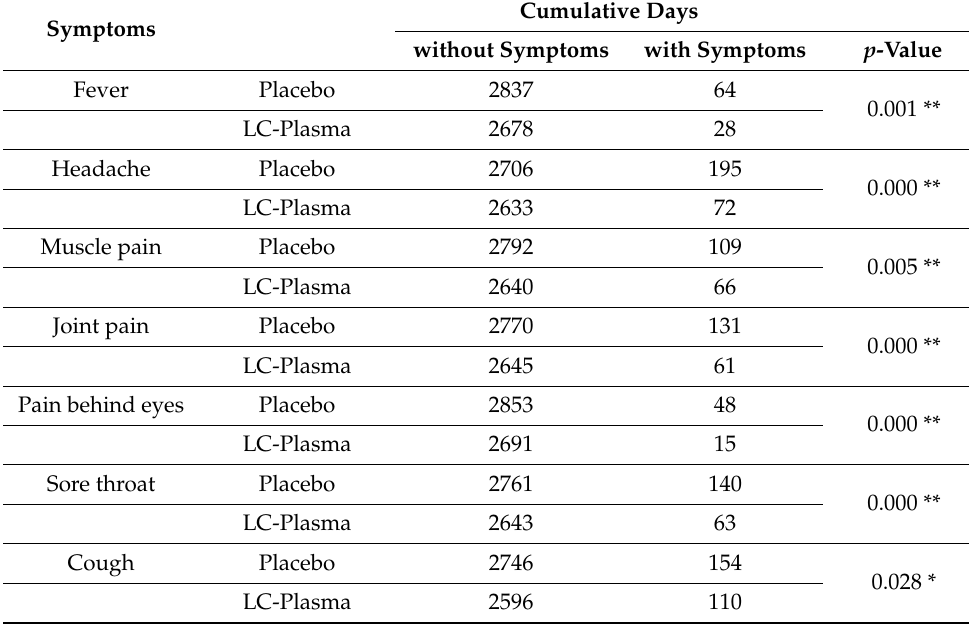
Table 3. Cumulative symptomatic